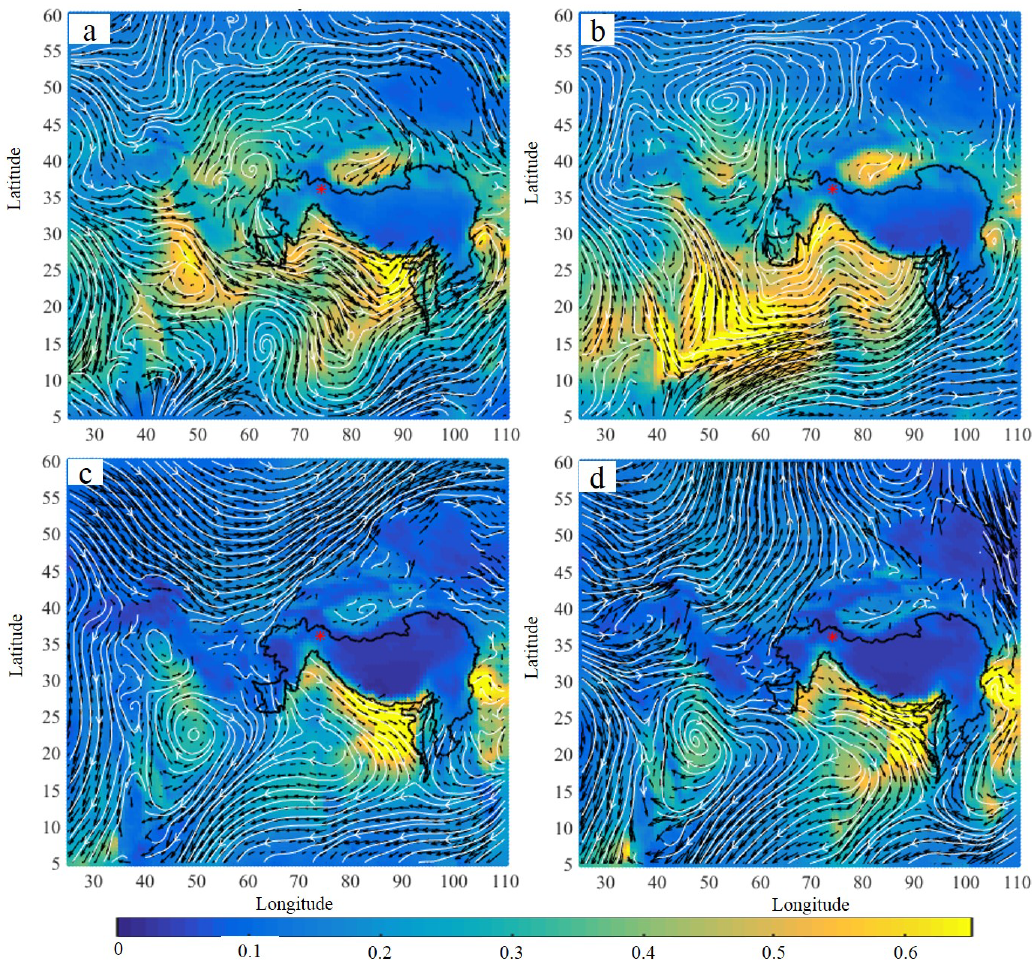
Figure 5. Monthly average horizontal wind patterns at 850hPa during (a) May, (b) June, (c) December, and (d) January, corresponding to approximately 2500ma.s.l., from NASA Goddard Earth Sciences (GES) Data and Information Services Center (DISC). Red star indicates the position of the study area, and white lines indicate streamlines. The background colors show monthly mean aerosol optical